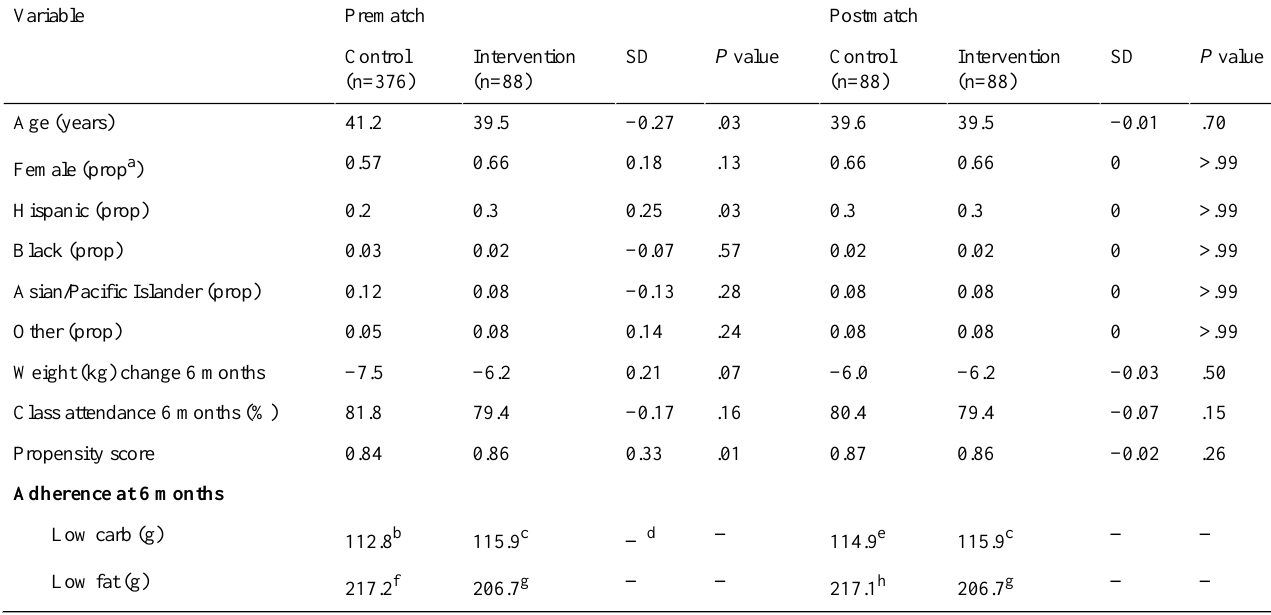
Table 1. Descriptive statistics for study variables in the electronic message group versus the control group pre- and postmatch. Means reported for age, weight change, class attendance; proportions reported for sex and race. SD=standardized difference (unitless measure of similarity, where closer to 0 is more similar). Variables with blank SD were not included in the